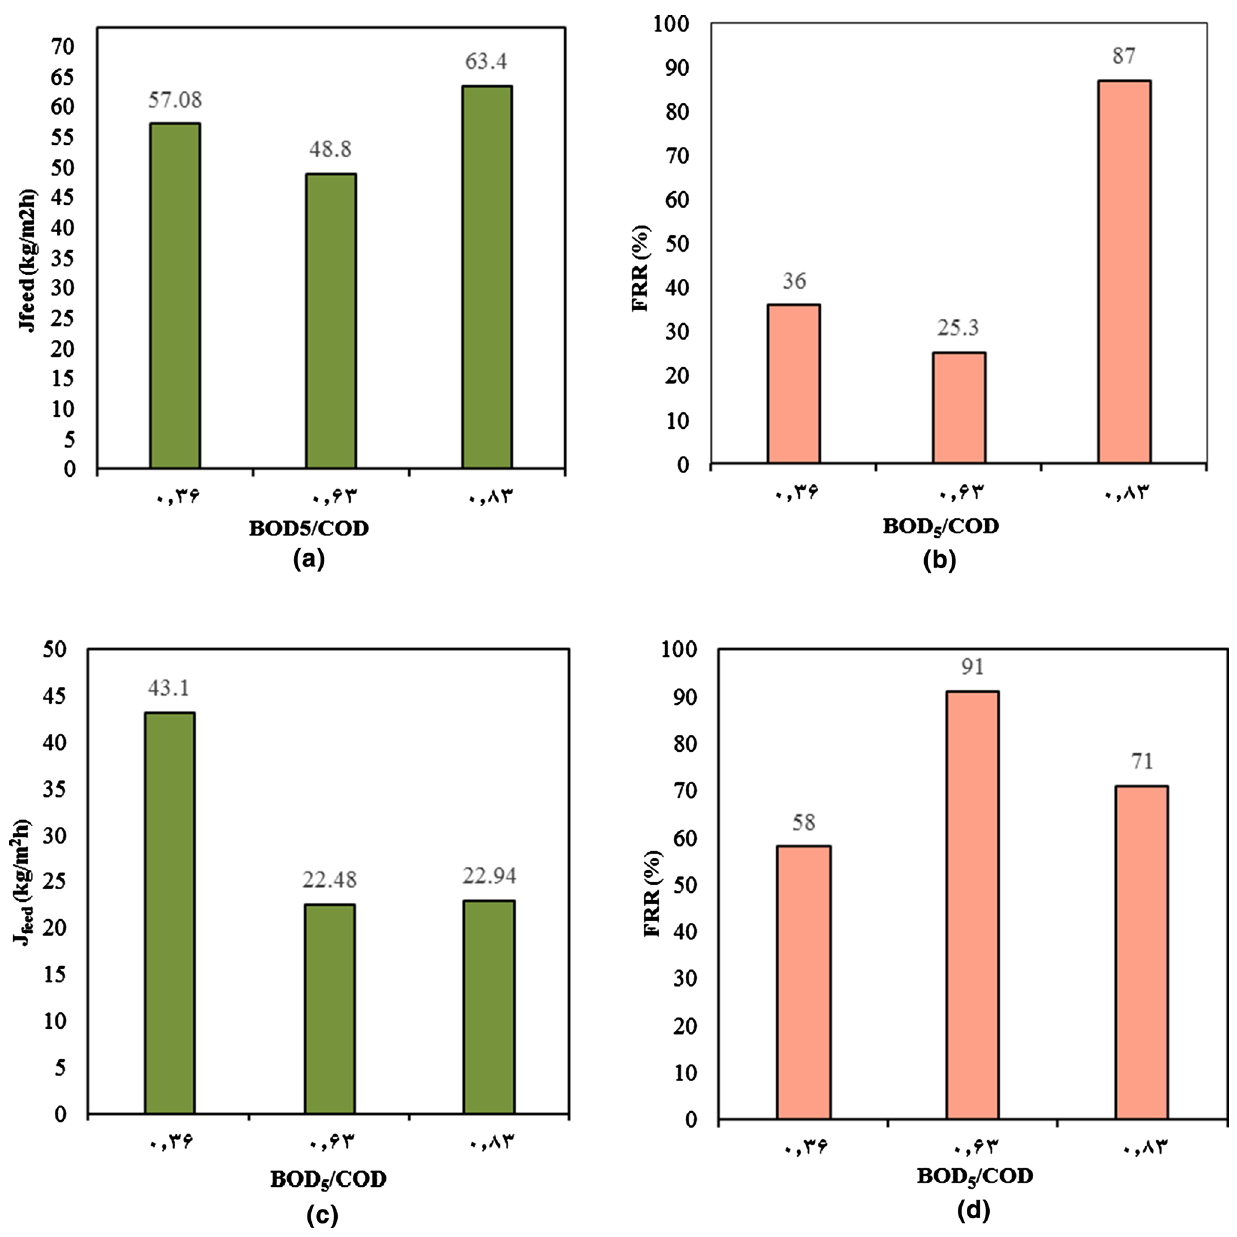
Fig. 13 J Feed ( a ) and FRR ( b ) measured for MF membrane at pressures of 15 psi and sures of 30 psi for type of